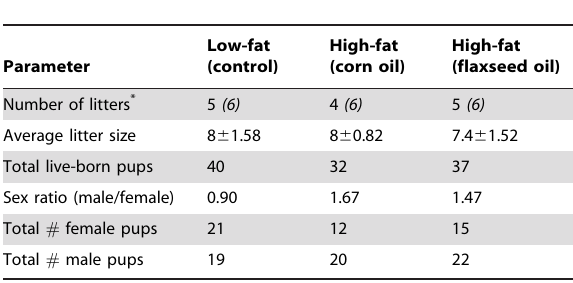
Table 1. Murine Offspring at